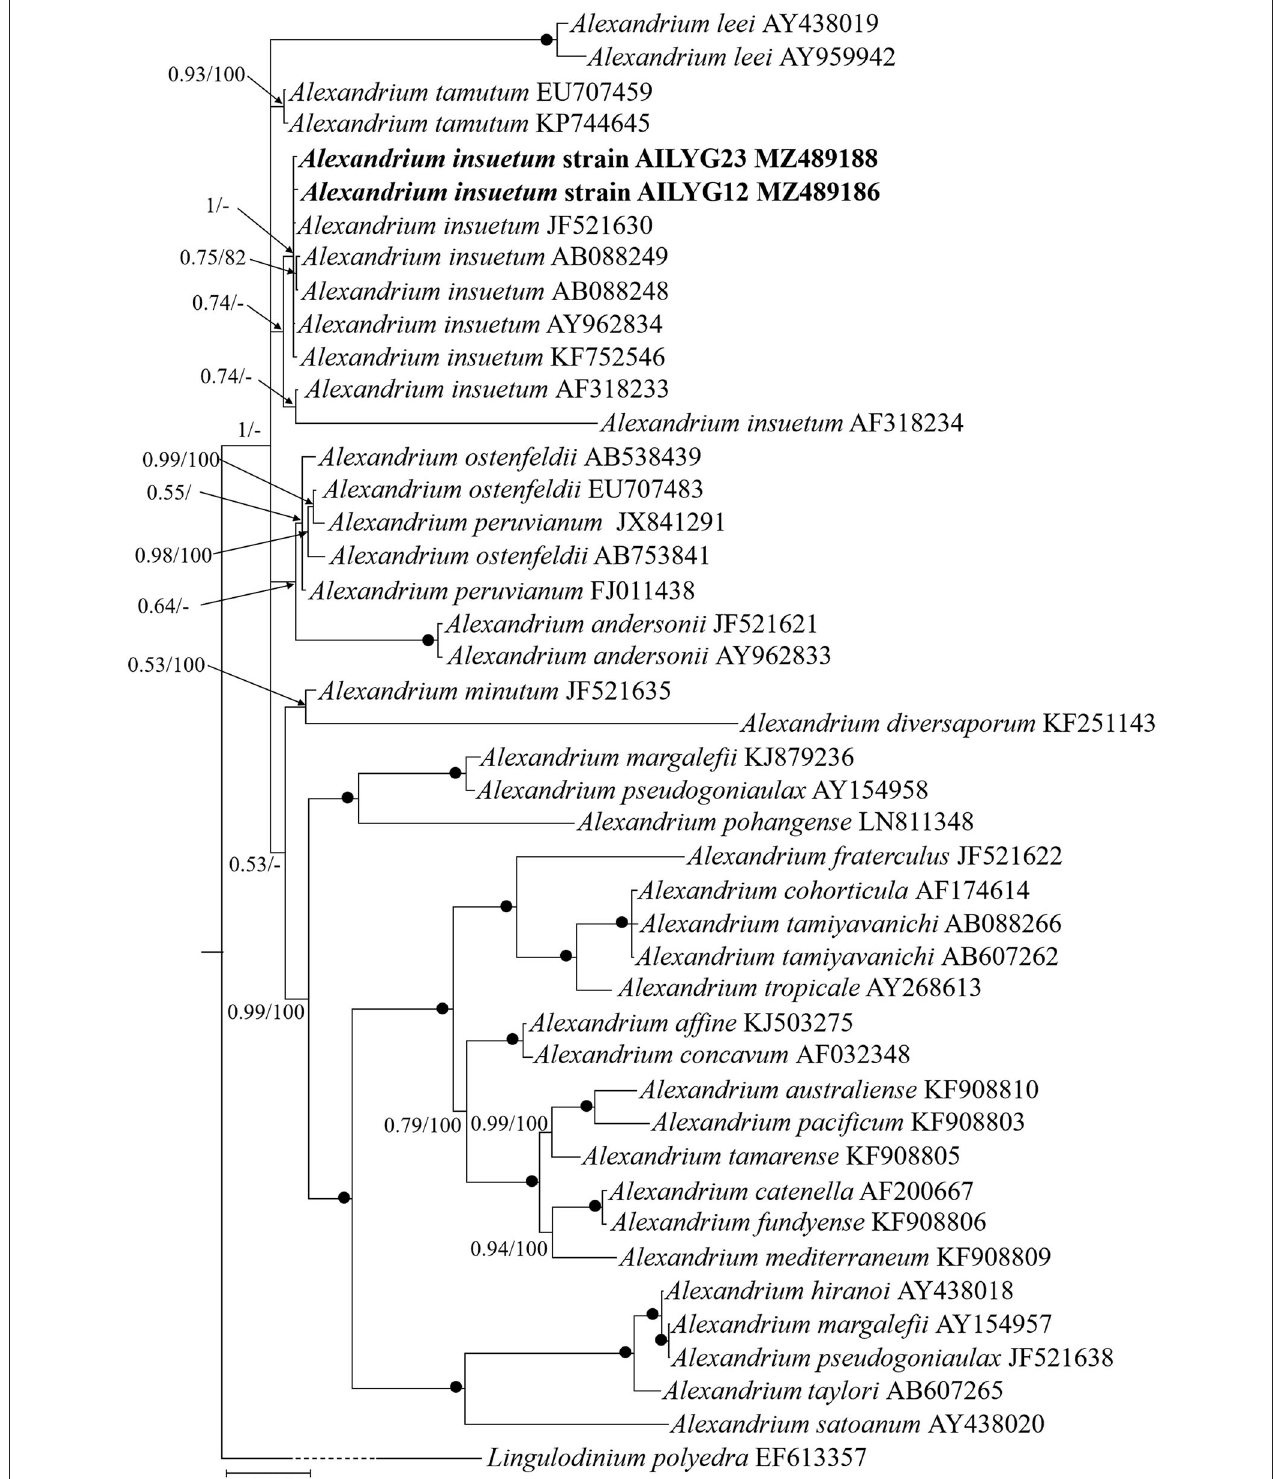
FIGURE 4 | Molecular phylogeny of Chinese strain of Alexandrium insuetum inferred from partial large subunit rDNA sequences based on Bayesian inference (BI) analysis with Lingulodinium polyedra (EF613357) as the outgroup. New sequences of A. insuetum are indicated in bold. Numbers on branches are statistical support values (left, Bayesian posterior probabilities; right, maximum likelihood (ML) bootstrap support values). Bootstrap values > 50% and posterior probabilities (pp) above 0.5 are shown. Black circles ( • ) indicate maximal support (pp = 1.00 in BI and bootstrap support = 100% in ML, respectively). All branches are drawn to scale.